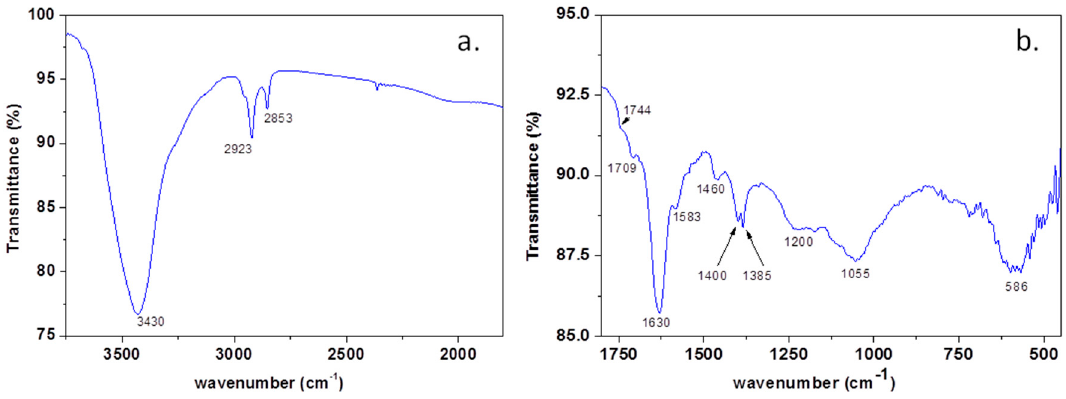
Figure 4. The FTIR spectrum of the graphene sample within 4000–2500 cm − 1 ( a ) and 2000–450 cm − 1 ( b ). The broad band between 1276–1135 cm − 1 is due to the overlapping of ‐ OH bending and C ‐ O ‐ C and B ‐ C stretching; 1100–950 cm − 1 , with maxima at 1055 cm − 1 of ‐ C ‐ O and B ‐ O ‐ B stretching; 670–500 cm − 1 , with maxima at 586 cm − 1 of O ‐ B ‐ O stretching [31,32,34].